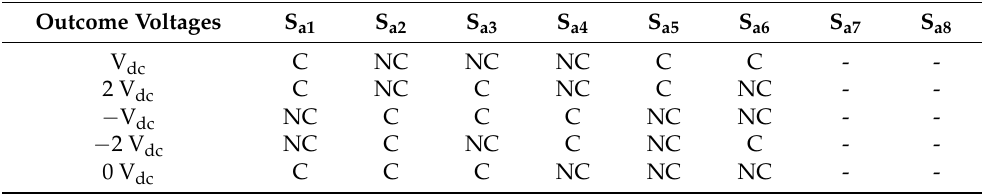
Figure 1. Schematic of the proposed three-phase 5-level symmetric RSMLI fed induction motor drive under healthy conditions. Table 1. Sequences of switching for the 5-level symmetric RSMLI structure under healthy conditions.